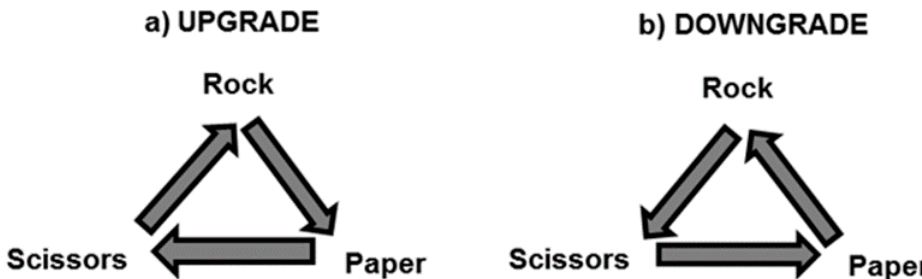
Figure 1. Recursive ( a ) upgrade and ( b ) downgrade item change strategies in rock, paper, scissors.